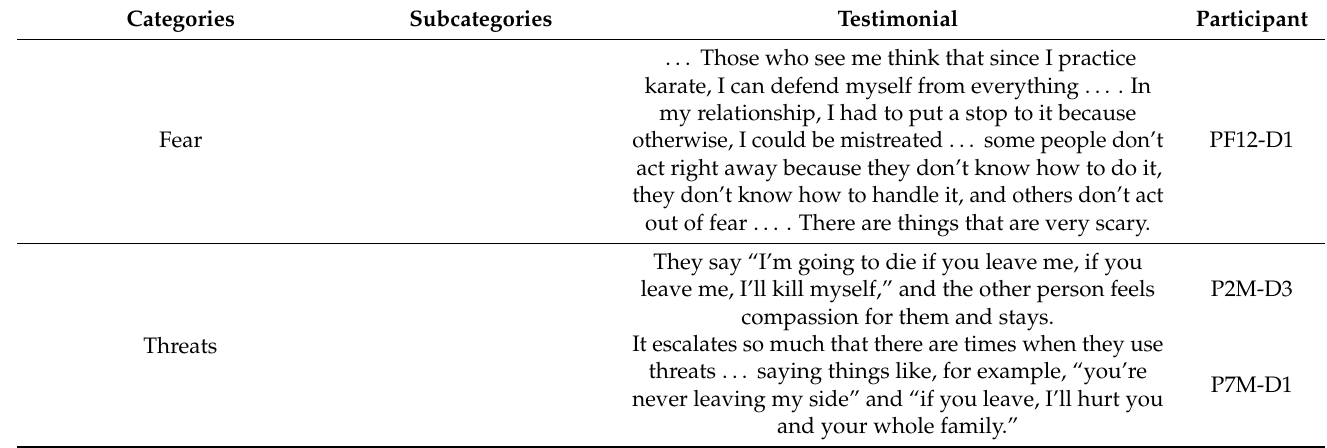
Table 3. Factors that hinder the prevention of and coping with